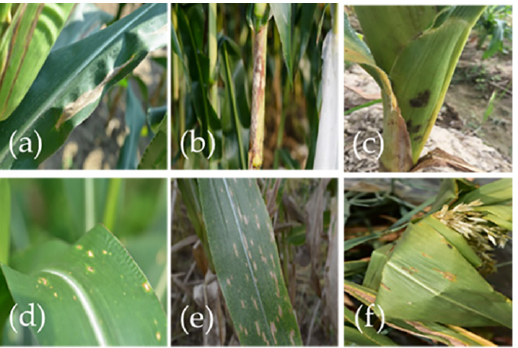
Figure 1. Corn disease samples. Note: ( a ) Own spot; ( b ) Northern leaf blight; ( c ) Sheath blight; ( d ) Curvularia lunata (wakker) Boed spot; ( e ) Bipolaris maydis ; ( f ) Common rust.